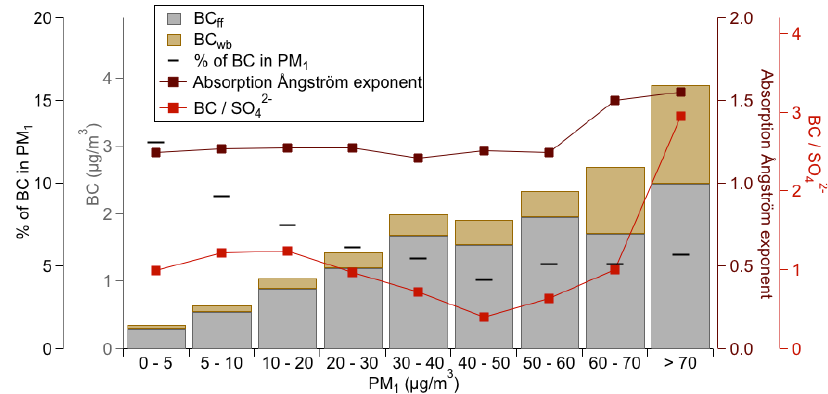
Figure 7. Source contribution to BC, absorption Ångström exponent, BC / SO 4 ratio (ACSM sulfate), and contribution of BC to PM 1 , depending on PM 1